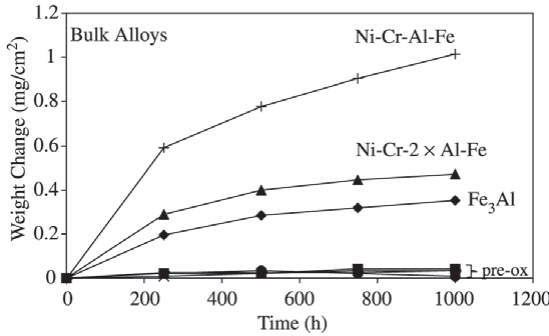
Figure 6. Corrosion test results of as cast and pre-oxidized bulk alloys exposed to N for 1,00 h at 850 °C.